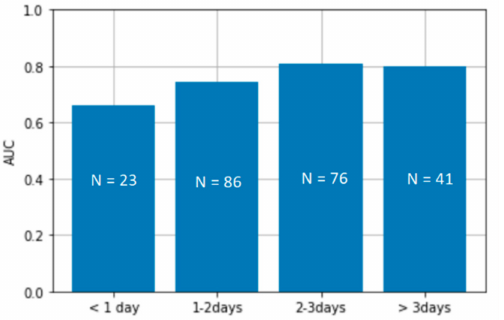
Figure 10. The PDA detection algorithm’s performance across cohorts of patients sorted by the days since birth when the recording was